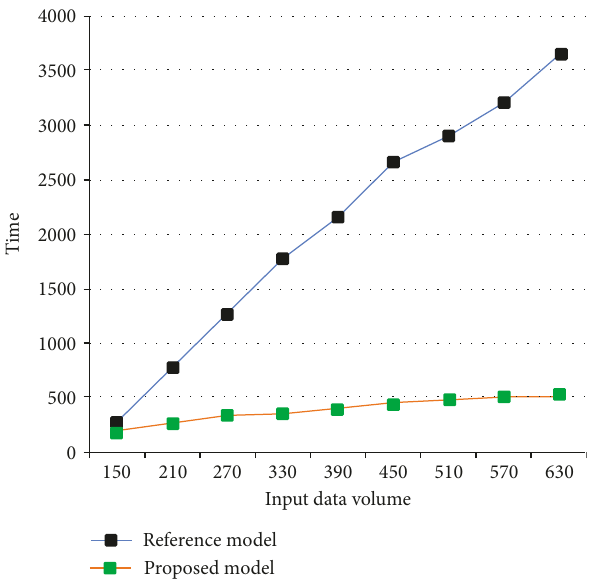
Figure 9: Distribution of source tracing results generation time.